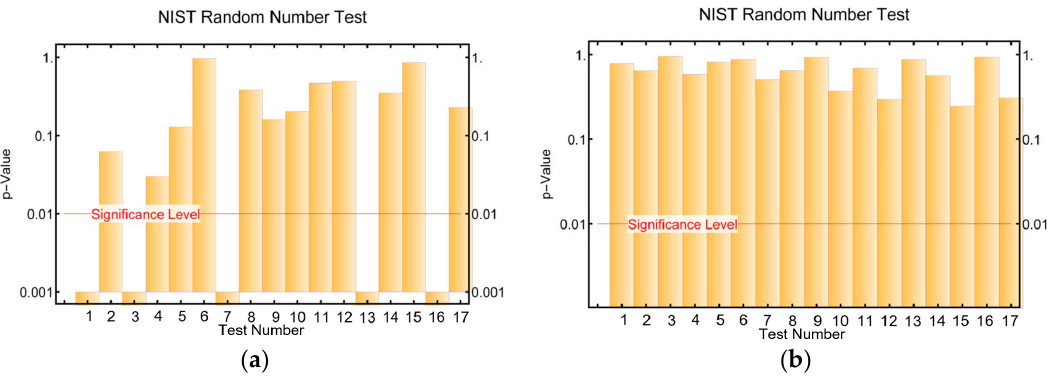
Figure 9. ( a ) NIST test results for bitstream obtained by sampling the sensor at 2.5 kSps; ( b ) NIST test results after applying the SHA-512 algorithm to that bitstream. The test numeration is the same as in